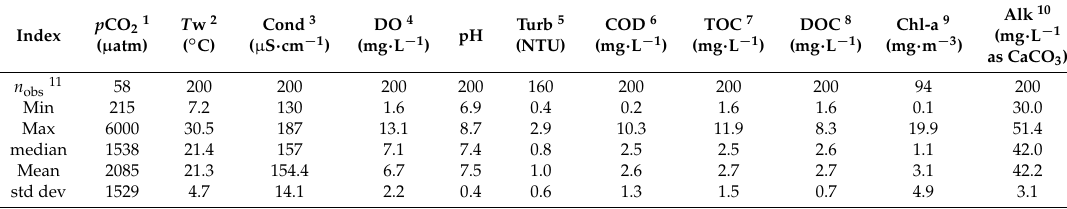
Table 1. Descriptive statistics of the observed